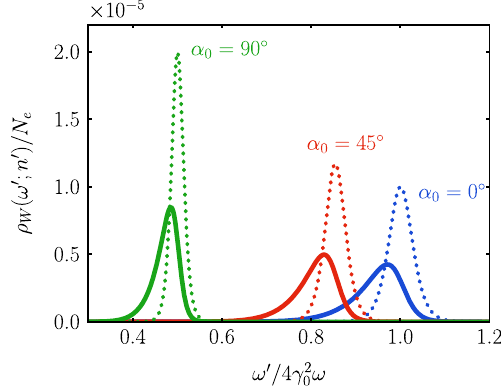
FIG. 2. Cold spectral density (dotted curves) vs warm spectral density (solid curves) at low intensity, a 0 ¼ 0 : 01 , and a laser pulse length of (cid:9) ¼ 18 observed in the direction of the incoming electron bunch n 0 k u 0 , i.e. (cid:3) ¼ (cid:6) 0 , (cid:4) ¼ ’ 0 , for different elec- tron incidence angles (cid:6) 0 , which are given in the plot. The spectral densities have been calculated for an energy of m(cid:2) 0 ¼ 0 : 001 and an 40 MeV with an energy spread of (cid:5) (cid:2)=(cid:2) 0 ¼ angular spread of (cid:5) (cid:6) ¼ 2 : 5 mrad .